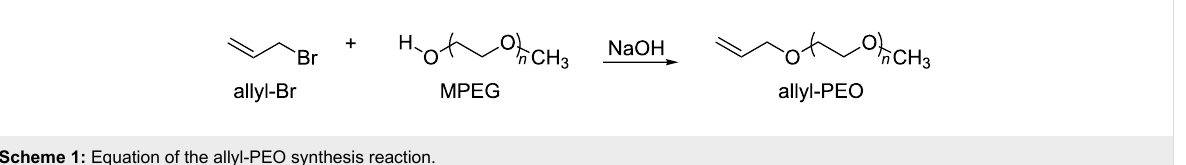
NMR. 1 H and 13 C NMR spectra were obtained on a Bruker FT-NMR 400 MHz